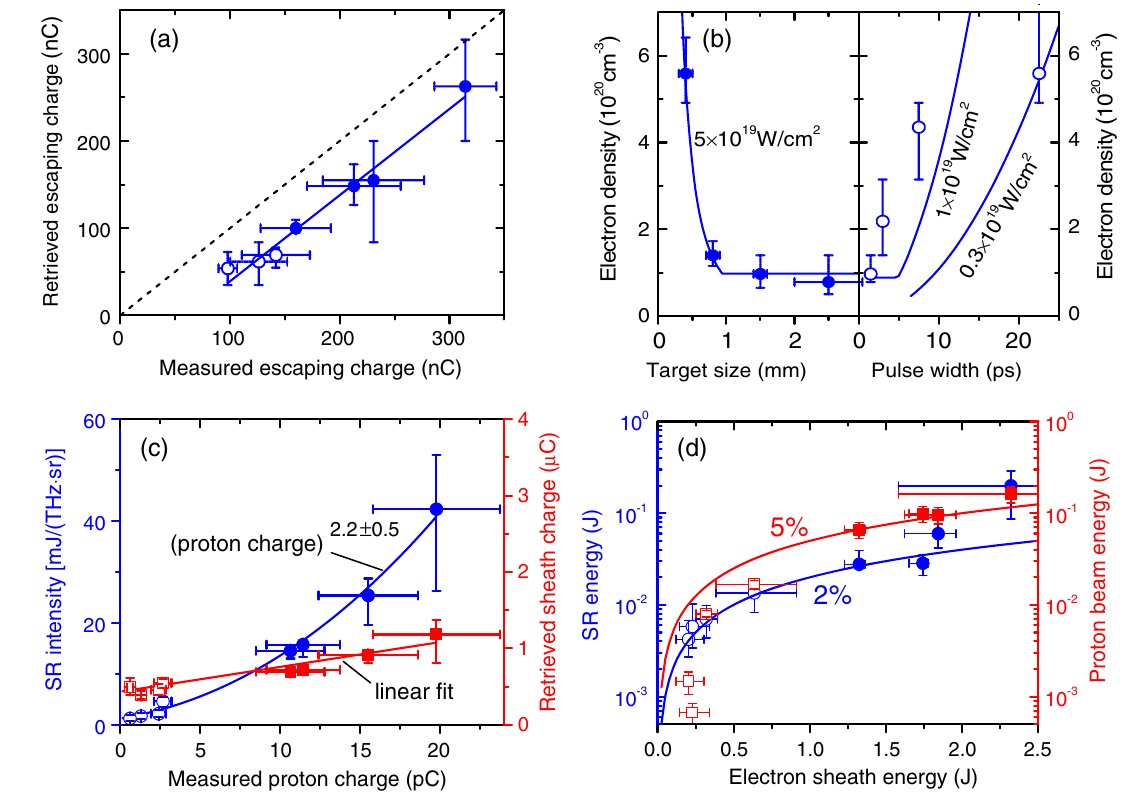
FIG. 3. Retrieval of laser-plasma characteristic quantities from the measured THz spectra. (a) Retrieved bunch charge of the escaping electrons as a function of the experimentally measured values. The solid line shows the linear fit to the data, and the dashed diagonal represents the retrieved values being equal to the measured ones. (b) Retrieved sheath electron density as a function of the target size and laser pulse duration. The curves represent theoretical evaluations at the constant laser energy absorption efficiency of 30% and indicated laser intensities. (c) Retrieved SR peak spectral intensity (blue circle) and sheath charge (red square), and their dependence on the proton charge measured with an ion spectrometer. The curves represent the power-law fit (blue) and linear fit (red), respectively. (d) Total SR energy (blue circle) and proton beam energy (red square) as a function of the retrieved electron sheath energy. The curves show the given energy conversion efficiency from the sheath. Solid and open marks represent the data set obtained, respectively, in the scan of target size [Fig. 2(b)] and pulse duration [Fig. 2(a)]. See Sec. VII for details on the experimental measurements of electrons and protons and the data analysis. Error bars on the retrieved values are the fitting uncertainties that correspond to the cyan band shown in Fig. 2. Error bars on the experimental values represent the shot-to-shot